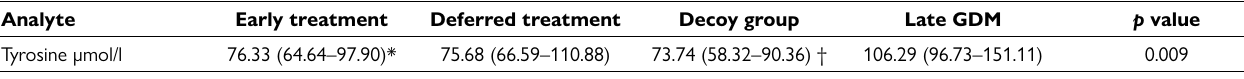
Table 2. Analytes of significance across all groups.